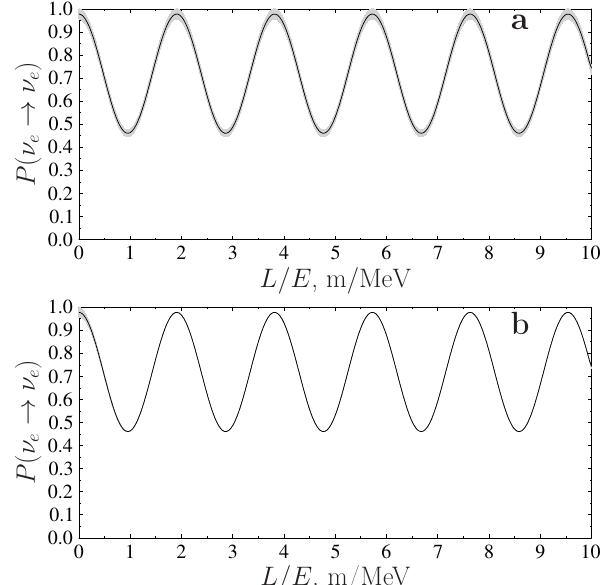
Figure 3. The survival probabilities for ν e depending on the ratio of the distance L from the source to the neutrino energy E in the beams of ν e for stable ( a ) and decaying ( b ) sterile neutrinos with masses m 4 = 1.14 eV, m 5 = 7 keV and m 6 = 1 MeV and with decay widths Γ 4 = 10 − 14 eV, Γ 5 = 10 − 7 eV and Γ = 10 − 5 eV. For matrix U = 0.087 and η = 15 ◦ ( η = 0 and η = 0). 6 mix , (cid:101) 2 3 4